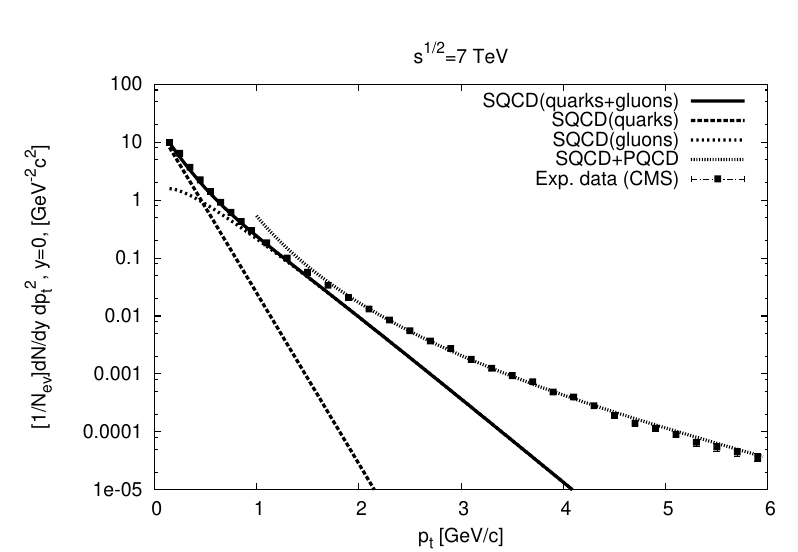
√ s = 7 TeV. The points